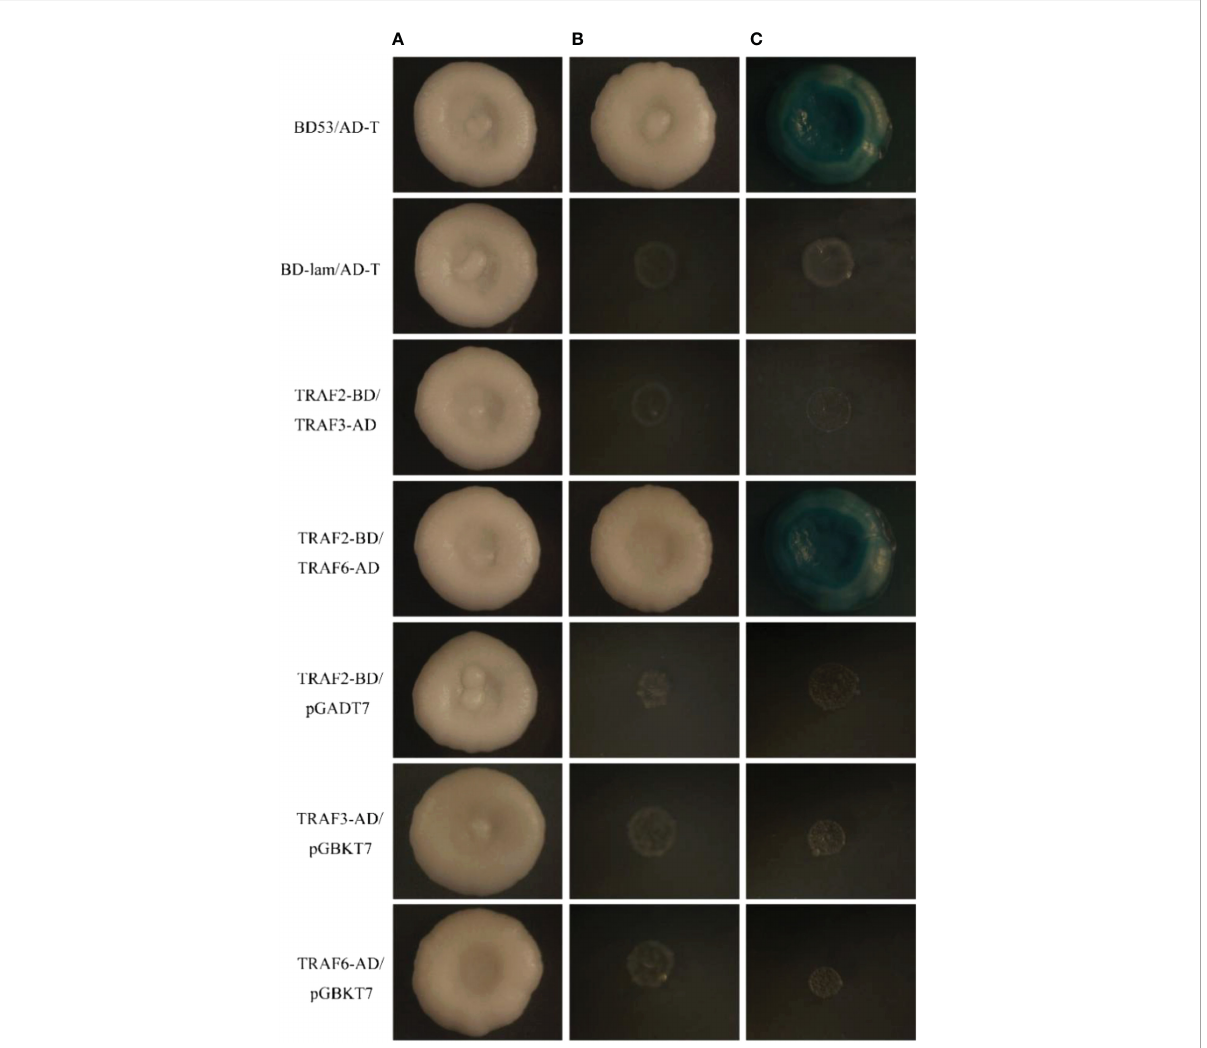
FIGURE 7 The yeast two-hybrid assay of PmTRAF2, PmTRAF3, and PmTRAF6. Co-transformed yeasts were cultured on SD/-Leu/-Trp medium (A) and SD/- Leu/-Trp/-His/-Ade medium (B) . Protein interactions were veri fi ed with SD/-Leu/-Trp/-His/-Ade medium containing x-a-gal (C) . AD represents pGADT7, and BD denotes pGBKT7. PGBKT7-53/PGADT7-T is the positive control group. pGBKT7-lam/pGADT7-T is used as the negative control group; pGBKT7-PmTRAF2/pGADT7- PmTRAF3 and pGBKT7-PmTRAF2/pGADT7-PmTRAF6 are expressed as experimental